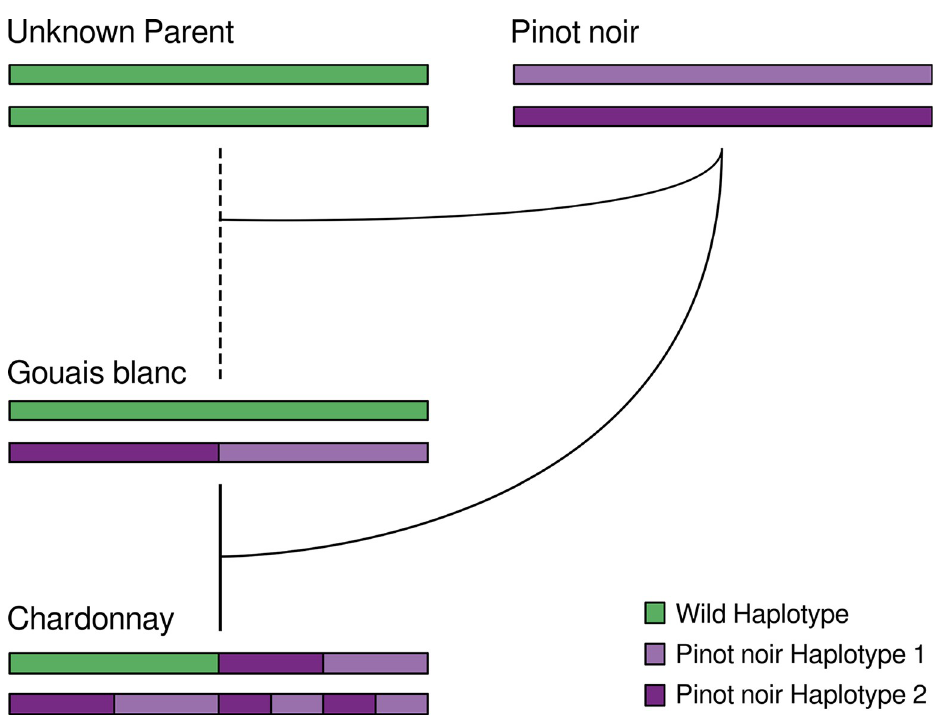
Fig 6. A schematic model for the complex pedigree of Chardonnay, Gouais blanc and Pinot noir. Two crossing events (akin to a standard genetic backcross) with Pinot noir would result in the homozygous and heterozygous Pinot noir regions present in